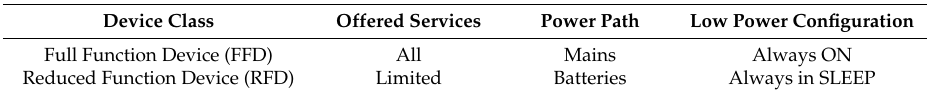
Table 1. Class of devices by means of IEEE